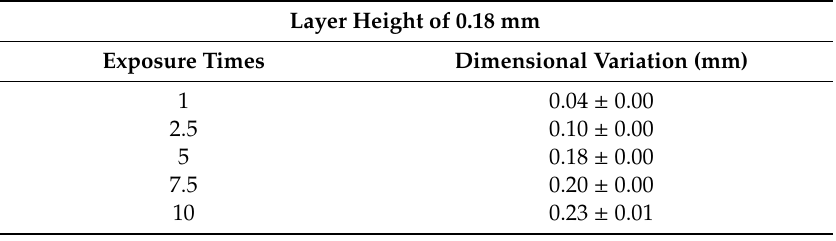
Table 5. Dimensional variation for each exposure time and layer height of 0.18 mm.